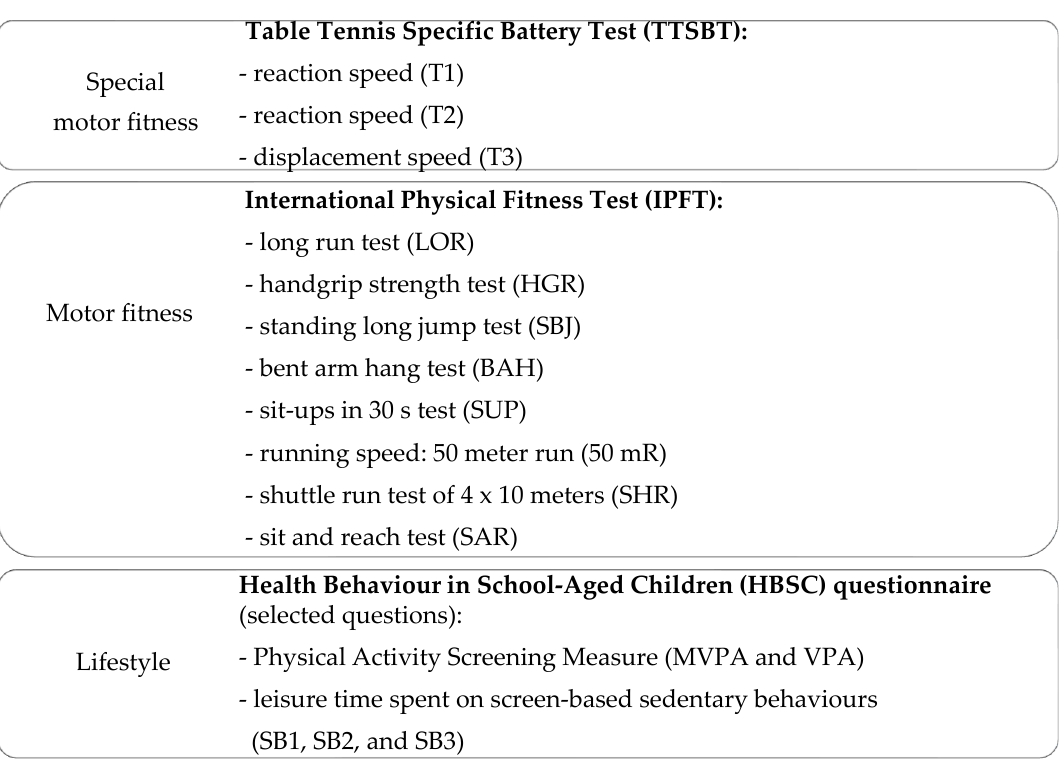
Figure 1. Recommended tests to gauge motor and leisure activity of young tennis players.